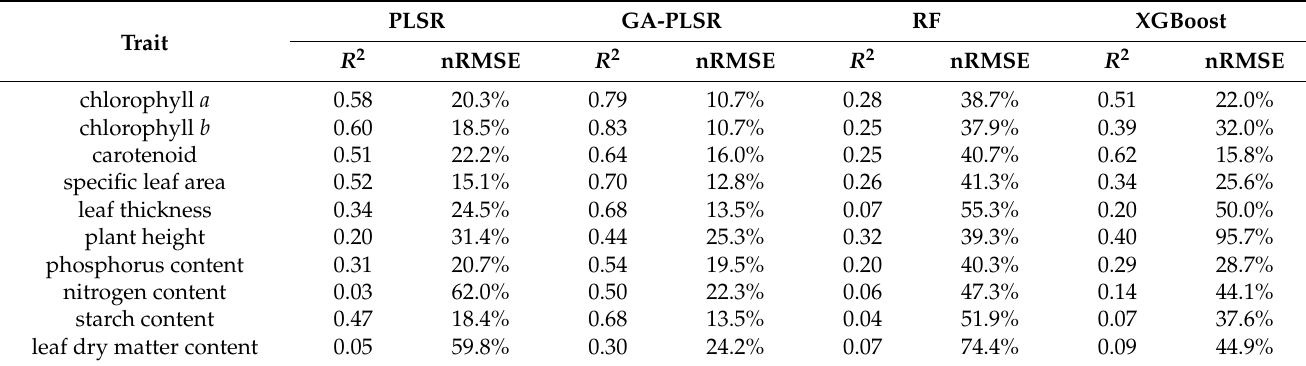
Table 1. Model evaluation and comparison of the coefficient of determination (R-squared) and normalised root mean-square error (nRMSE) on 10 plant community traits.